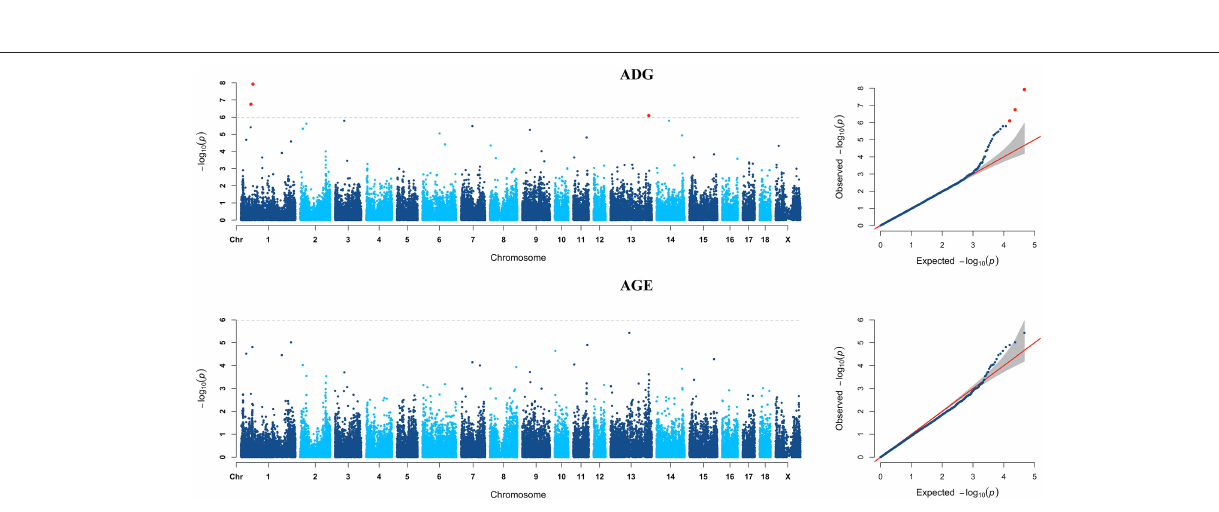
FIGURE 4 | Manhattan plots and Quantile-Quantile (QQ) plots for both ADG and AGE traits of Yorkshire breed. The signals of genome-wide significant SNPs are colored in